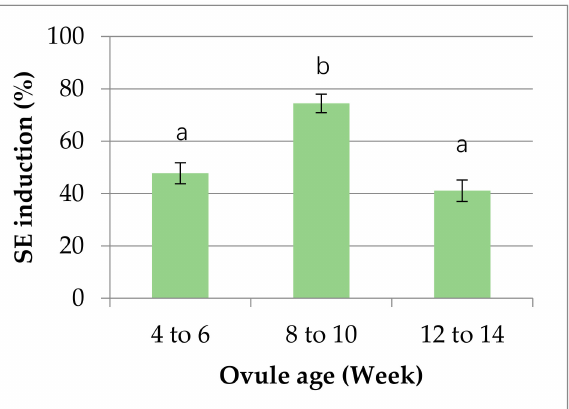
Figure 2. Effect of ovule age on embryonic callus induction. Data were recorded after 6–8 weeks of incubation. All explants of the individual age group (i.e., 4 to 6) from all three cultivars on all three media were considered as one group. The statistical difference ( p ≤ 0.05) among the means was analyzed by Duncan’s multiplerange test using SPSS (version 23), and results were expressed as mean ± standard error of three independent